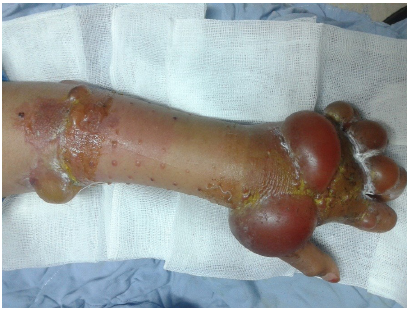
Figure 1. A double non-displaced fracture in the distal radius and ulna of her left arm.